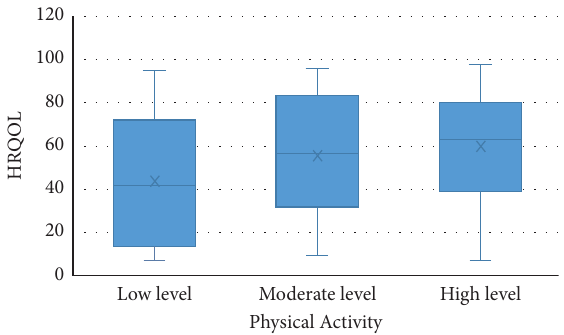
Figure 3: Association between physical activity and HRQOL.